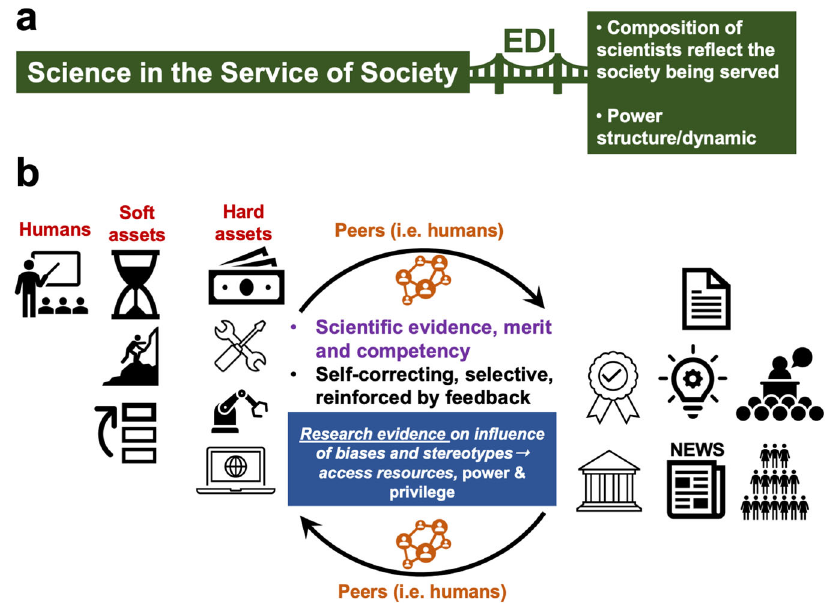
Fig. 1 Illustration of the scienti fi c culture. The top section ( a ) shows that EDI efforts aim to bridge the gap between practicing science to serve society and the composition of scientists and power structure/dynamics within scienti fi c fi elds. The lower section ( b ) highlights the ingredients for doing science, which include humans, soft, and hard assets (left side). The right side highlights the different forms of scholarly outputs and recognitions. The middle section highlights the role of peers in evaluating the scienti fi c evidence, merit and competency of scientists, and the prized notion that science is self- correcting, selective, and reinforced by feedback. See text for